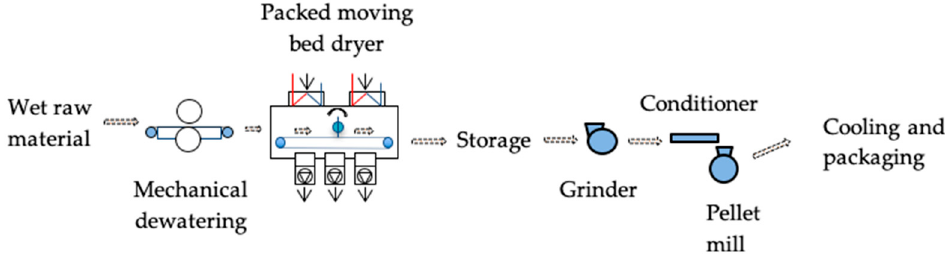
Figure 3. The setup for including a mechanical dewatering press before the PMB dryer in a pellet production chain.